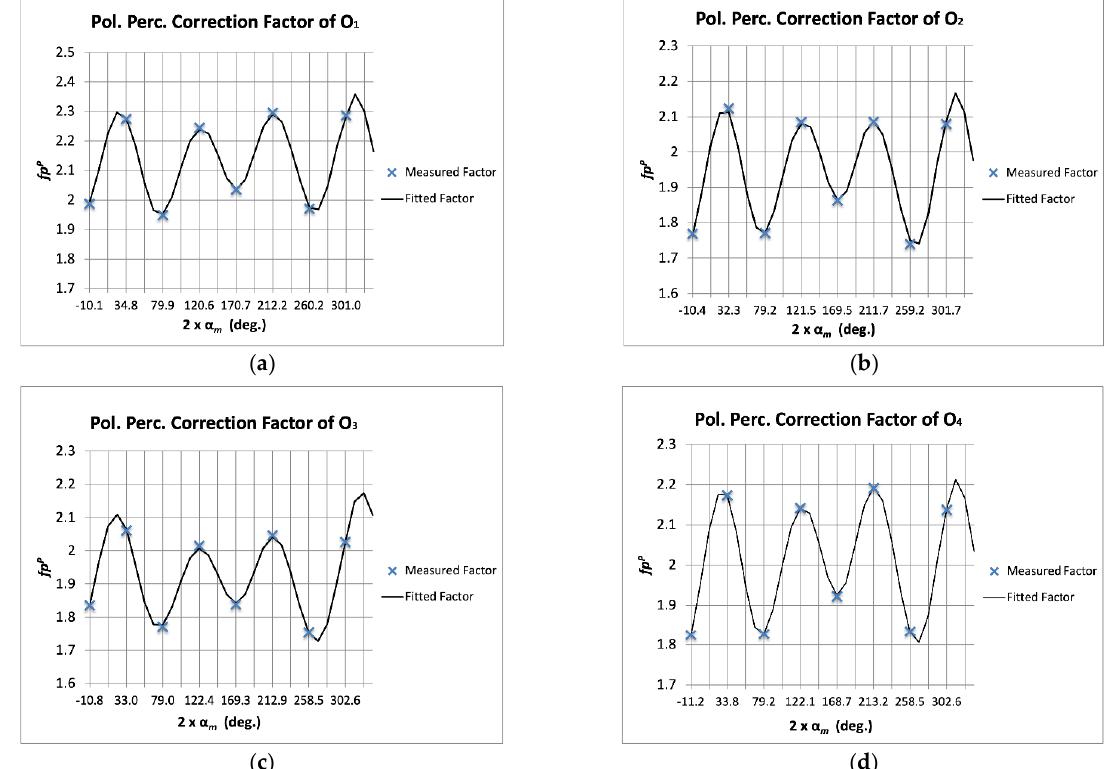
Figure 5. Measured polarization percentage correction factors ( fp Pm , blue crosses) superposed to the fitted ones ( fp Pf , black traces) with five multiplicative terms, given as a function of the measured polarization angles ( α m ) and for each one of the polarimeter outputs: O 1 ( a ), O 2 ( b ), O 3 ( c ), and O 4 ( d ).